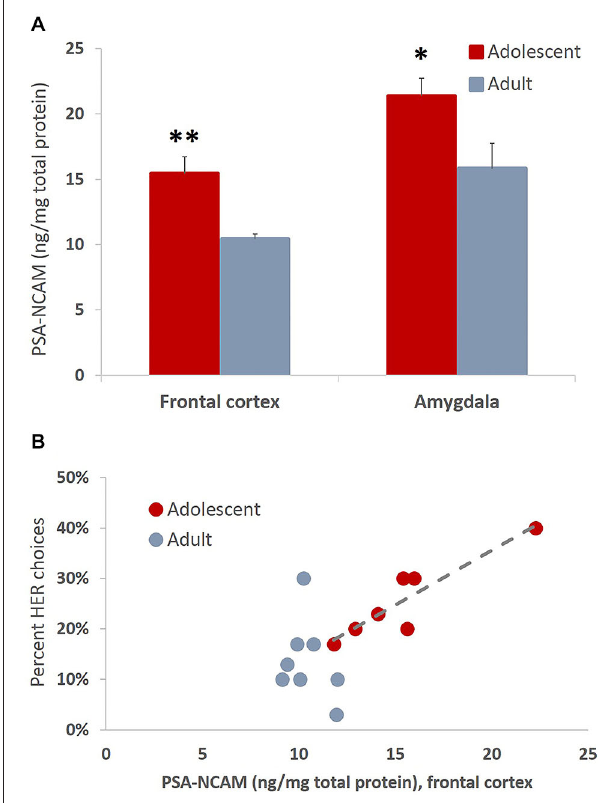
FIGURE 8 | Developmentally-specific patterns of PSA-NCAM expression are associated with greater effort expenditure toward larger rewards . (A) The bar graphs represent the concentration of PSA-NCAM (ng/mg of total protein) + SEM. The levels of PSA-NCAM were increased in frontal cortex and amygdala in late adolescent compared to adult animals that had been trained on an effortful reward valuation task. (B) PSA-NCAM levels in PFC were strongly and positively associated with HER choices when considering the entire cohort of animals and in adolescents alone, but not in adult animals considered independently. The regression line is given for the adolescent group only * p < 0.05, ** p <